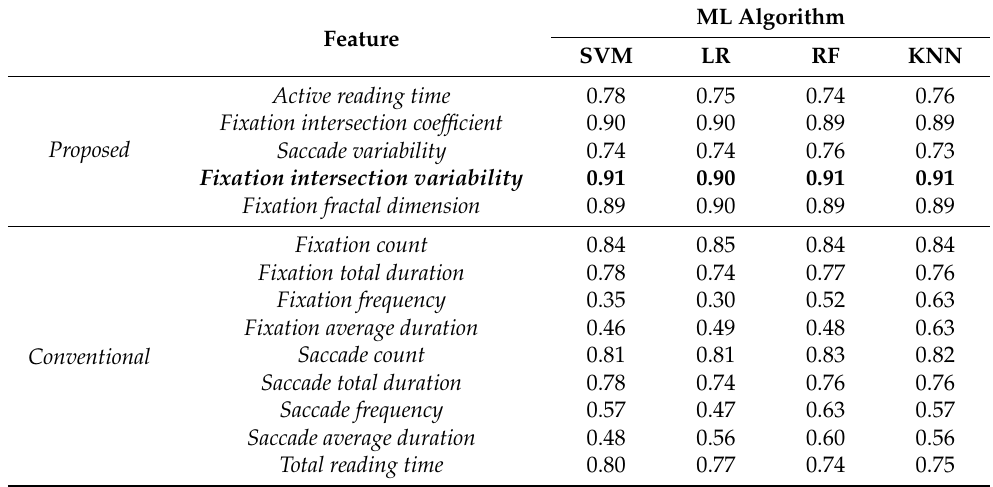
Table 3. Classification accuracies for single feature inputs.